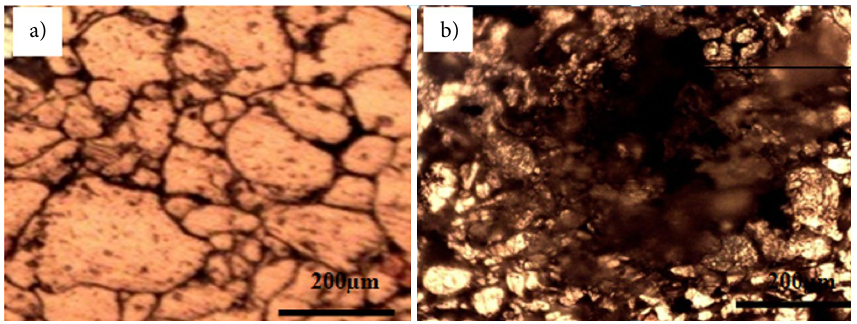
Figure 9. Micrographs image for (Al-4.5% Cu-1.5% Mg) base alloy before (a) and after corrosion (b)